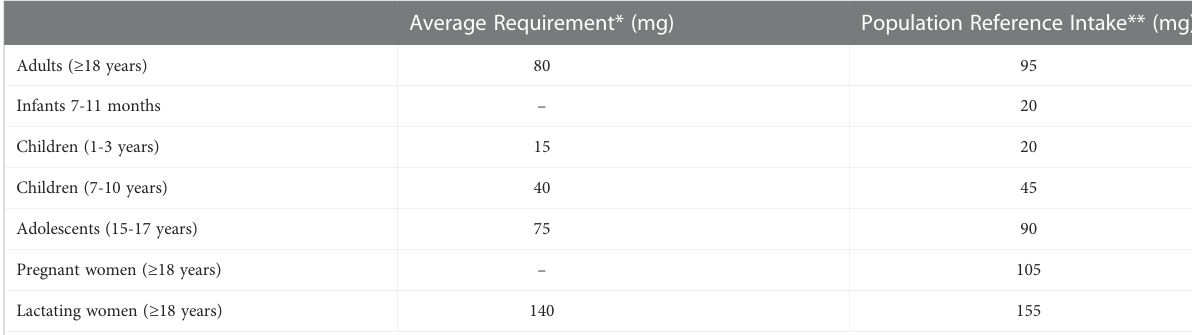
TABLE 1 Ascorbic acid requirement (mg/day) in different subsets of the population, according to the European Food Safety Authority. http://